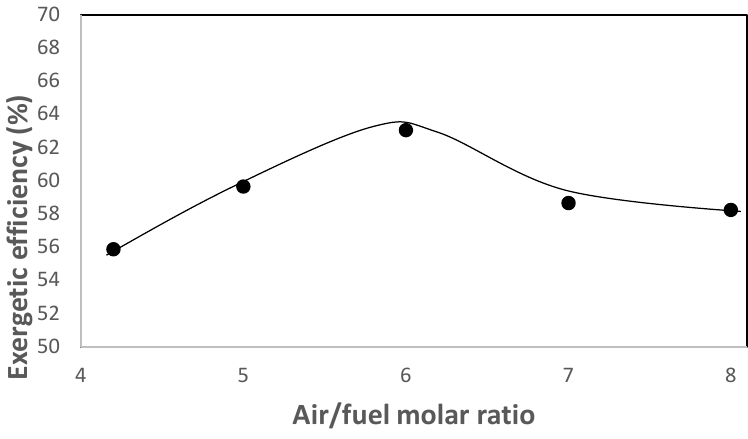
Figure 5. Evolution of exergetic efficiency vs. air/fuel molar ratio.